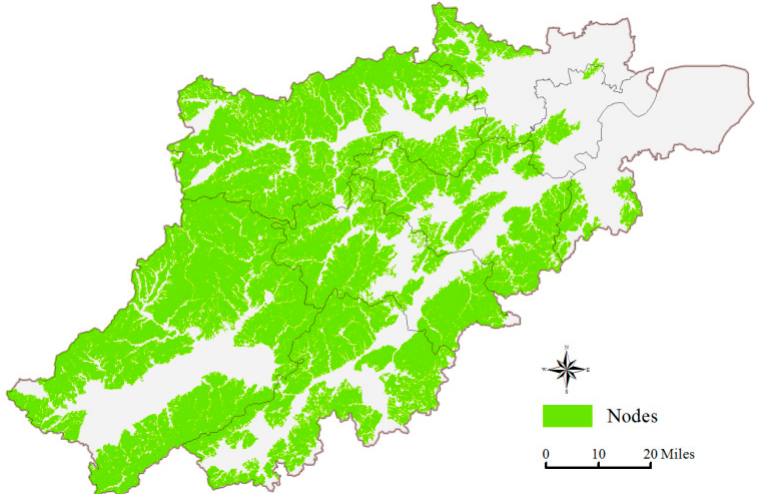
Figure A2. Spatial patterns of the R, K, LS and CP factors of farmland within the study area.